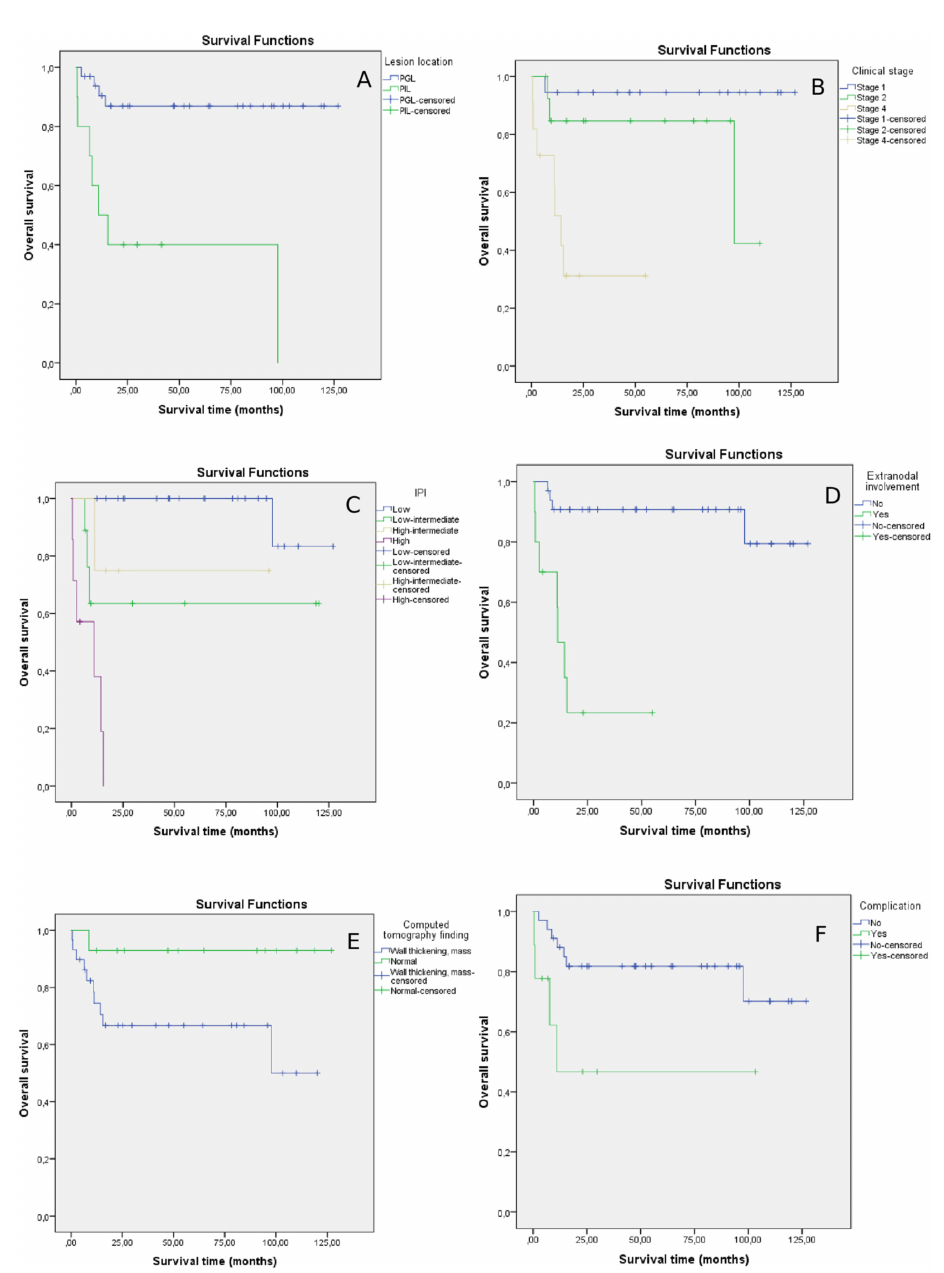
Figure 1. Univariate analysis: OS (A) according to the lesion location ( P < .001). OS (B) according to the clinical stage ( P < .001). OS (C) according to IPI ( P < .001). OS (D) according to the presence of extranodal involvement ( P < .001). OS (E) according to CT finding ( P = .047). OS (F) according to the presence of complication ( P =